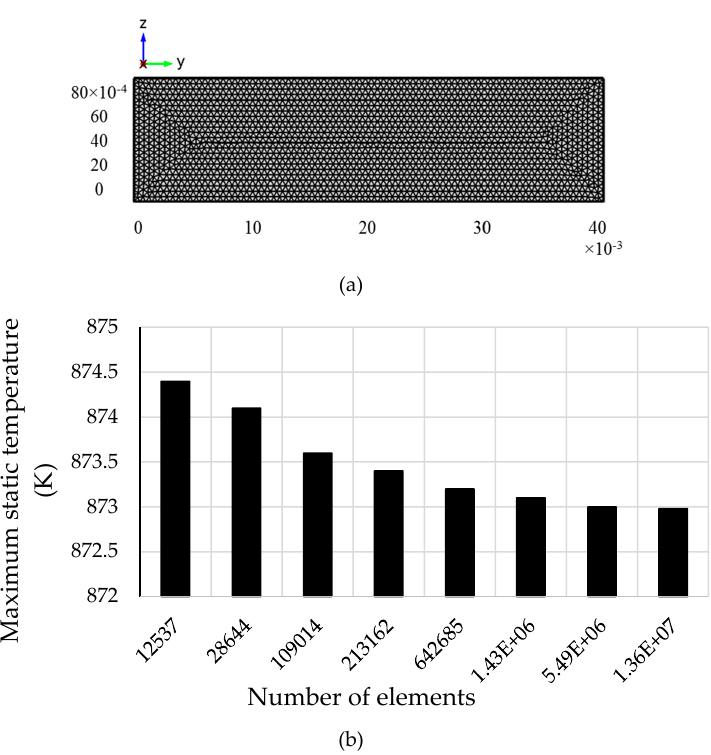
Figure 3 . ( a ) Generated mesh for the Therminol model and ( b ) stability of the maximum static temperature of the receiver for different grid systems.